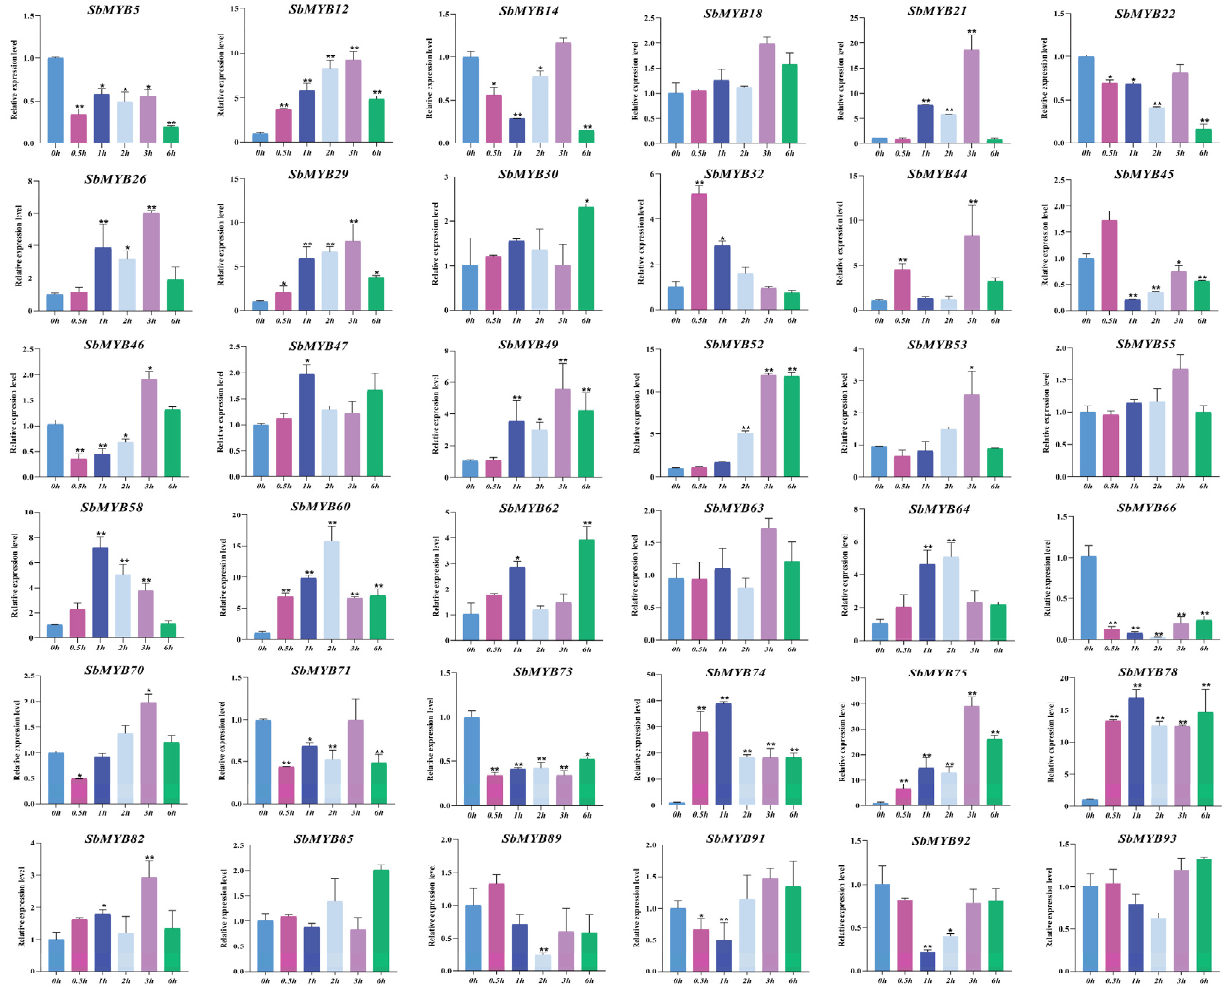
Figure 9. Response to MeJA treatments of 36 selected R2R3-SbMYB genes. The reference gene was SbACT7. Comparing the experimental and control groups (0 h), statistically significant differences are indicated by * p < 0.05, ** p < 0.01.